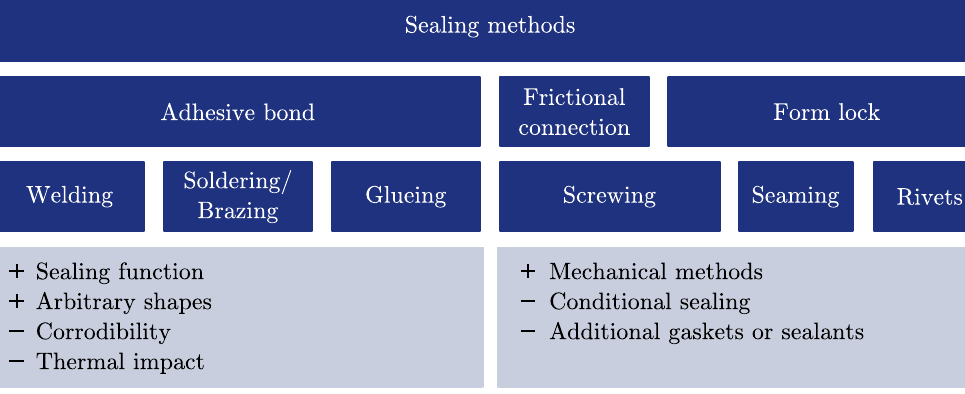
Figure 4. Summary of different sealing methods which can be applied to macro-encapsulated phase-change materials.